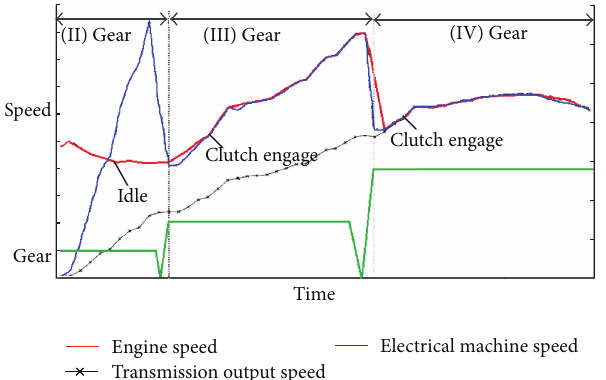
Figure 3: Gear shifting process of the PHEV with EMT.